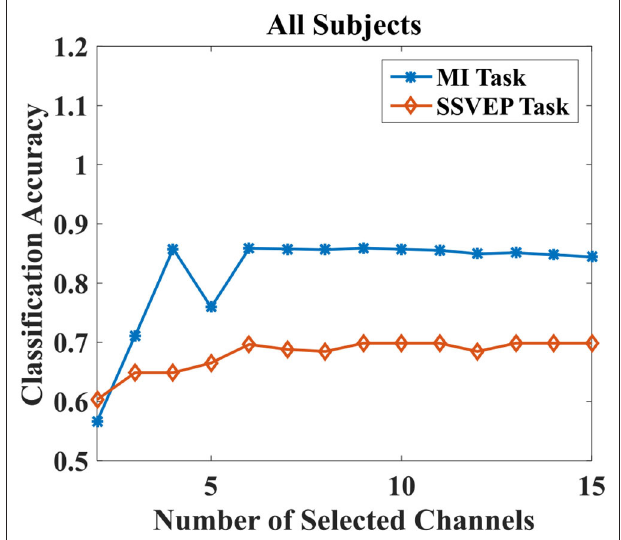
FIGURE 4 | Average classification accuracies for MI and SSVEP tasks with different numbers of selected channels for all subjects.